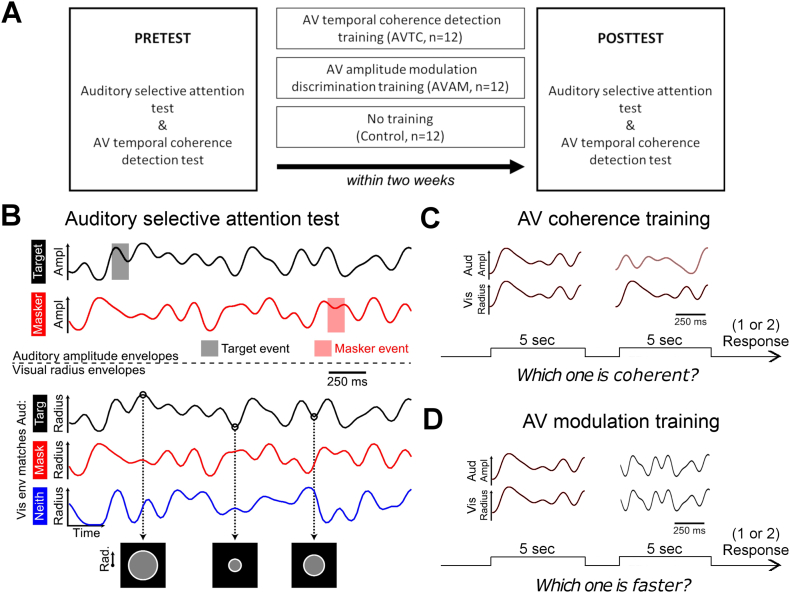
A Experimental design. B Schematic representation of auditory and visual stimuli used in the auditory selective attention test (panel was taken from Maddox et al., 2015). Amplitude envelopes of target (black) auditory stream and masker (red) auditory stream and visual radius envelopes for three auditory visual (AV) coherence conditions; target coherent (black), masker coherent (red) and neither (blue). Examples frames of the visual stimuli at three radius level. C Schematic representation of AV temporal coherence detection test/AV coherence training. Two 5 seconds AV pairs were used. One maintained some degree of temporal coherence (left, here fully coherent) while the other was always fully independent (right) D Schematic representation of AV amplitude modulation rate discrimination (AV modulation) training. Two 5 second temporally coherent AV pairs were used. Each pair had a different modulation envelope (and rate) but stimuli were always temporally coherent across modalities.